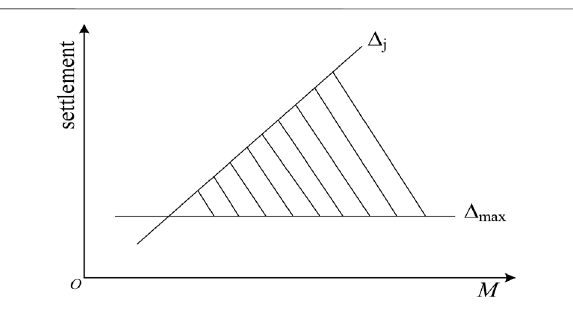
FIGURE 4 | Discrimination diagram of the structural morphology of the critical